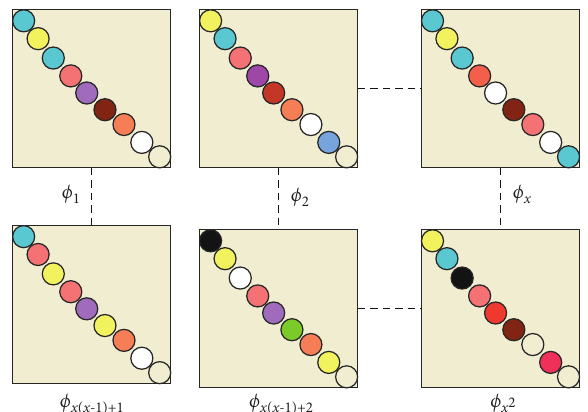
Figure 3: Style of sampling matrix.